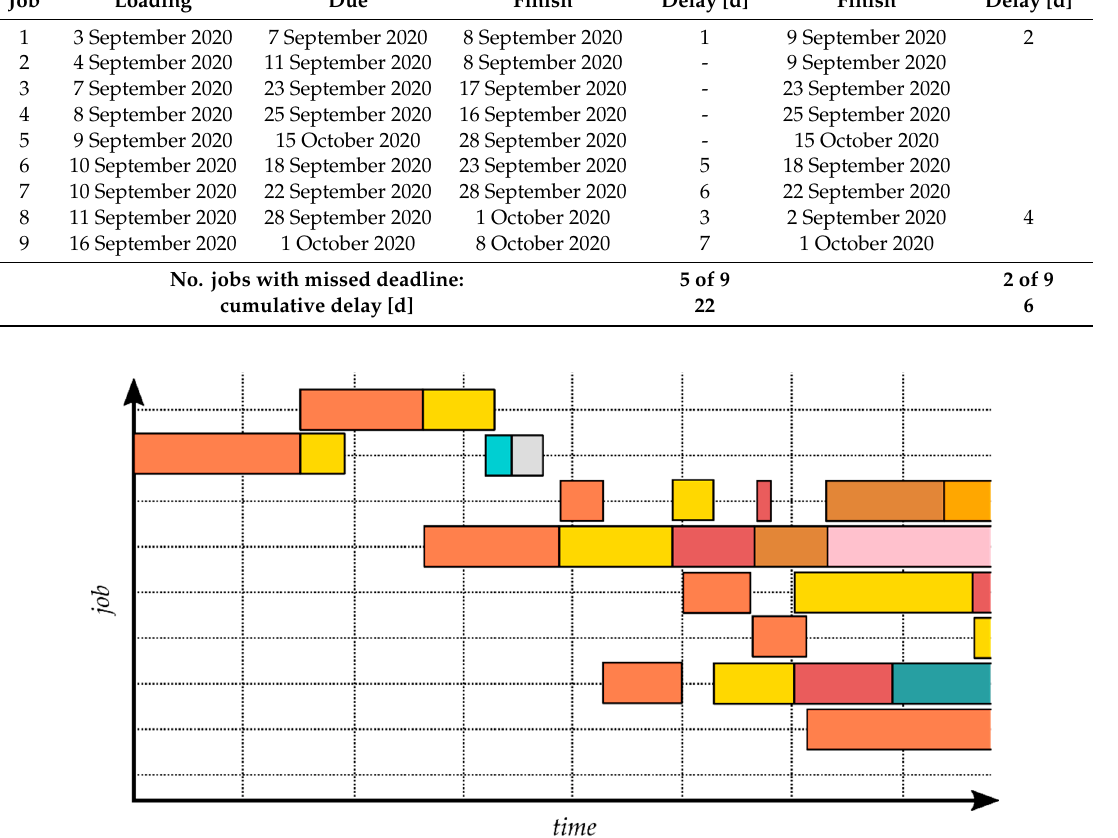
Table 1. Performance on the batch before and after sequence optimization for the use-case.